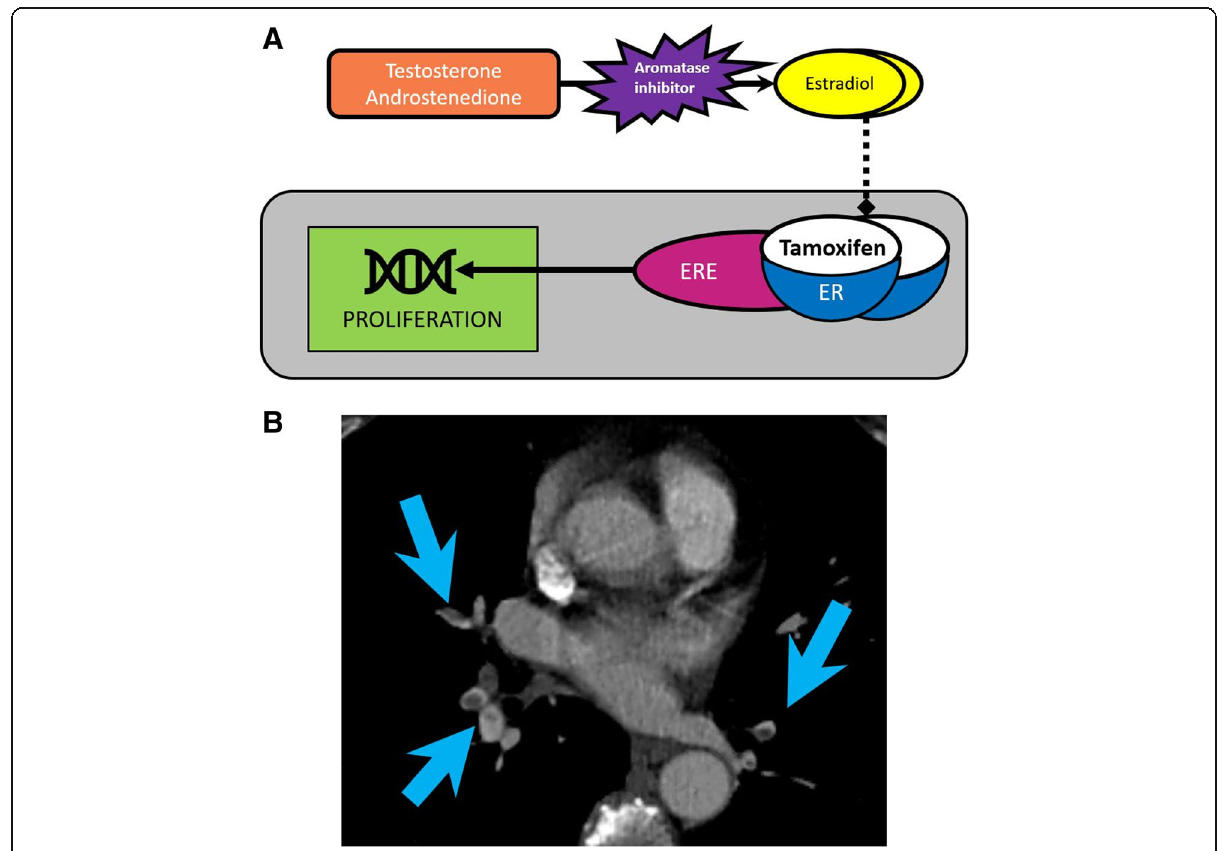
Fig. 2 Transcriptional regulation pathway by steroid hormones. a Image showing the role of aromatase inhibitors and tamoxifen in blocking steroid synthesis. Estradiol binds to estrogen receptor (ER), leading to dimerization and binding to estrogen response elements (ERE) activating estrogen-responsive genes leading to proliferation. Tamoxifen competes with estradiol for ER binding aromatase inhibitors decreasing the synthesis of estrogens from their precursors. b Contrast-enhanced CT images of the chest and abdomen in a 72-year-old woman with ER + invasive lobular breast cancer treated with letrozole (aromatase inhibitor) and tamoxifen. CT of the chest shows multiple filling defects in the bilateral segmental pulmonary arteries (arrows), compatible with pulmonary embolism, an adverse event associated with